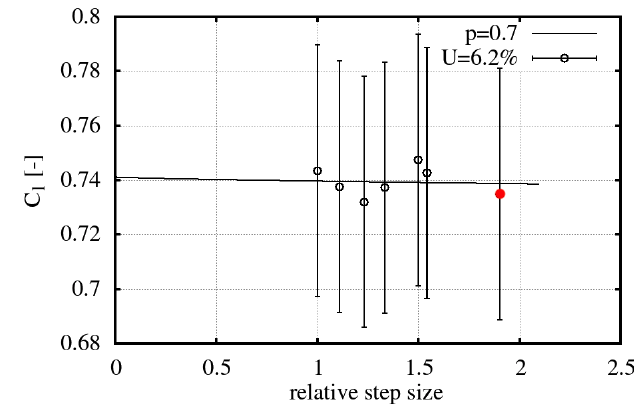
Figure 22. Convergence of the